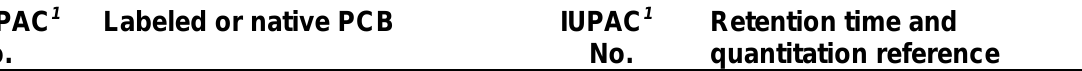
Matrix and Concentration Water Other Extract (pg/l) (ng/Kg) (pg/ ::